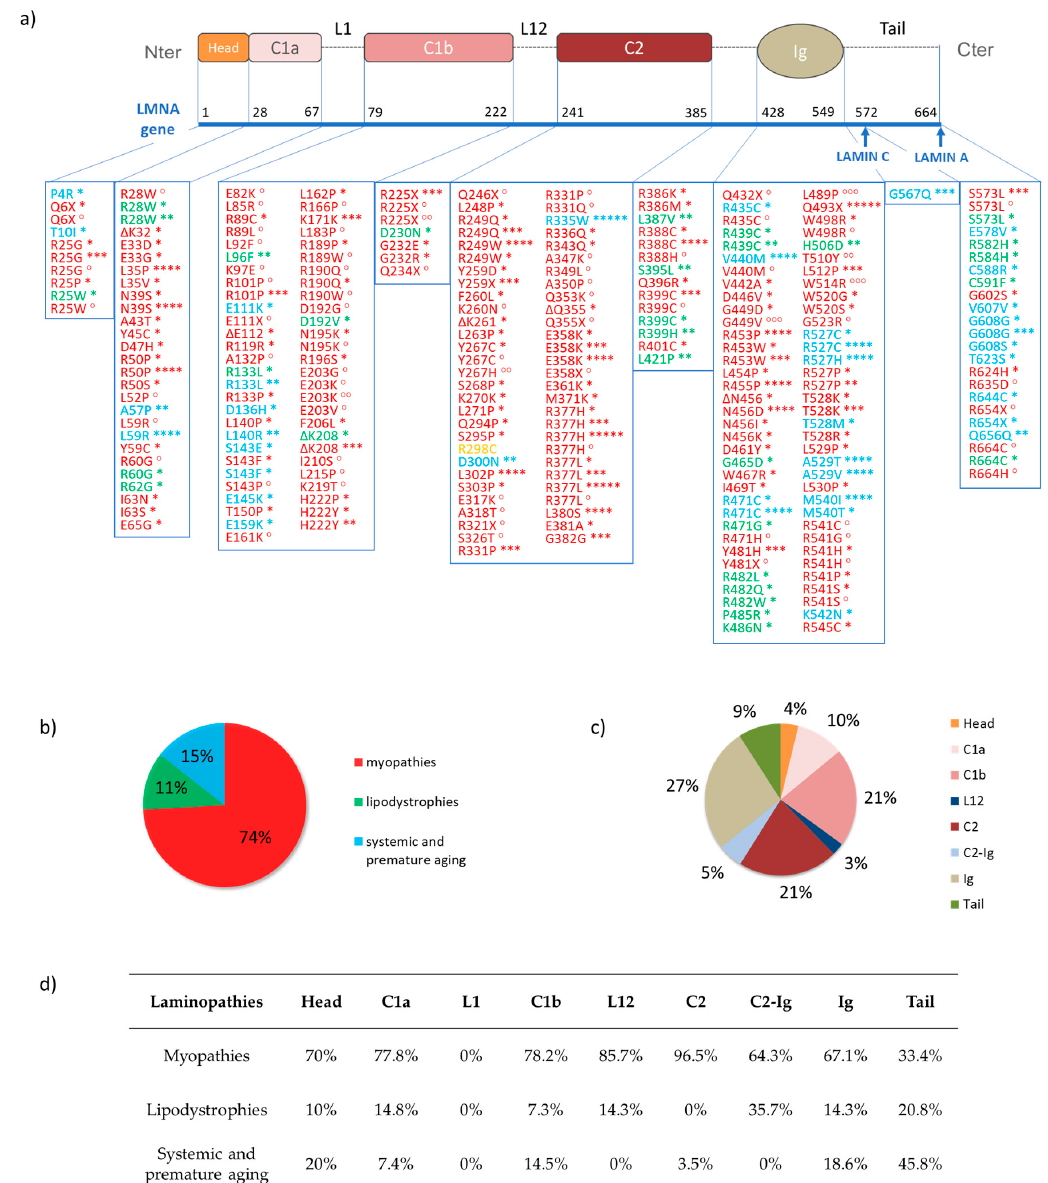
Figure 8. The single-point mutations of the LMNA gene. ( a ) List of LMNA gene mutations graphically associated with distinct lamin domains. Red indicates the gene mutations related to the following myopathies: EDMD2 (*), EDMD3 (**) LGMD1B (***), CMD (****), AS-SMA (*****), CDM1A (°) and DCM-CD (°°); mutations associated with various uncategorized phenotypes of muscular dystrophy, as reported by Dialynas et al. [182] are also reported in red (°°°). In green, those regarding lipodystrophies: FPLD2 (*) and MS (**). In yellow, the mutations causing the CMT2B1 neuropathy. Finally, blue indicates the gene mutations relative to systemic and premature aging disease: HGPS (*), WRN (**), RD (***), MADA (****), HHS (*****). ( b ) The percentages for each group of laminopathies. Almost 74% of the single-point mutations cause myopathies. Premature aging and lipodystrophy are 15% and 11%, respectively. Only one mutation has been associated with neuropathy. ( c ) The percentages for each lamin domain. Ig-fold domain, C2 and C1b involve most of the known mutations, representing 27%, 21%, and 21% of the entire set of mutations, respectively. They are followed by C1a (10%), tail (9%), the domain between C2 and Ig-fold (C2-Ig) (5%), the head (4%), and finally L12 (3%). No mutations have been correlated with L1. ( d ) Table collecting the percentages related to the mutations classified according to both the domain and the group of